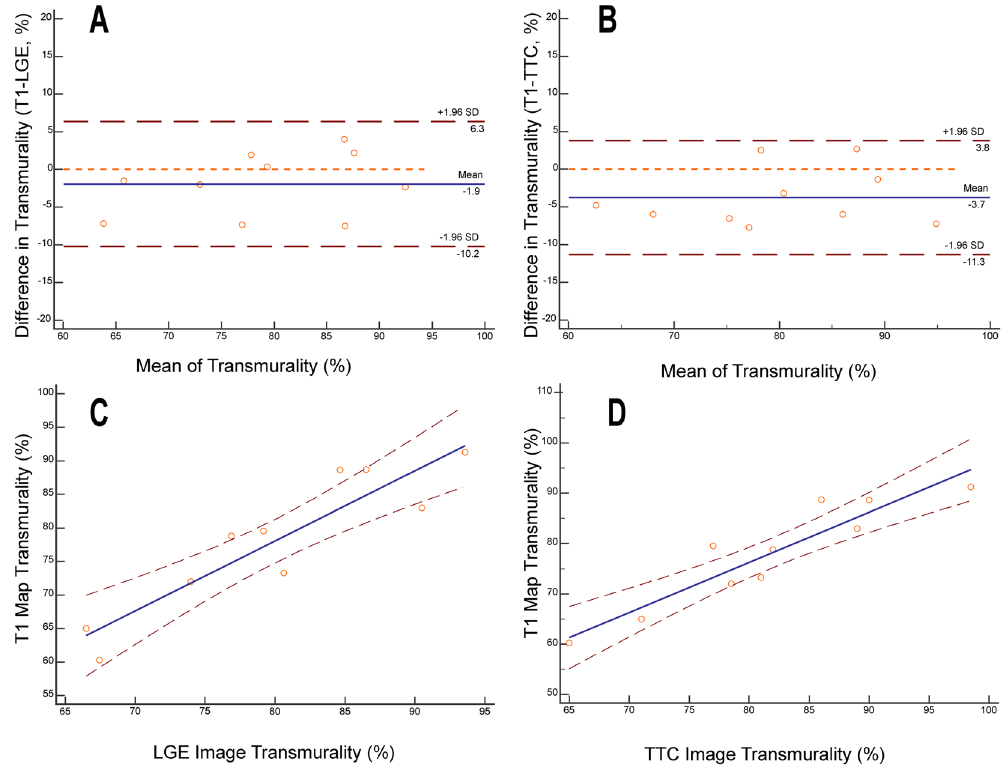
Figure 4. Transmural extent of myocardial infarction assessed by T1 mapping, LGE imaging and TTC staining. Legend: Bland-Altman analysis shows good agreement between the T1 maps and LGE images ( A ) as well as the T1 maps and TTC staining images ( B ) in regard to determining the transmural extent of myocardial infarction. The blue line indicates the mean of infarct size. The dashed red line indicates 95% CI. There is good correlation between LGE images and T1 maps, y = − 5.61% + 1.05x, R 2 = 0.84, p = 0.0002, ( C ) as well as TTC staining images and T1 maps, y = − 3.39% + 1.00x, R 2 = 0.86, p = 0.0001, ( D ) for determining the transmural extent of myocardial